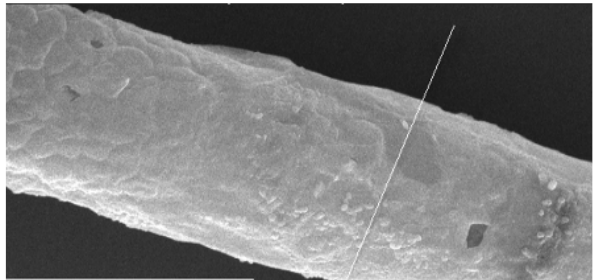
Figure 8. High-magnification SEM photograph of hydroxyapatite fibers. Reproduced from [31] with permission from John Wiley and